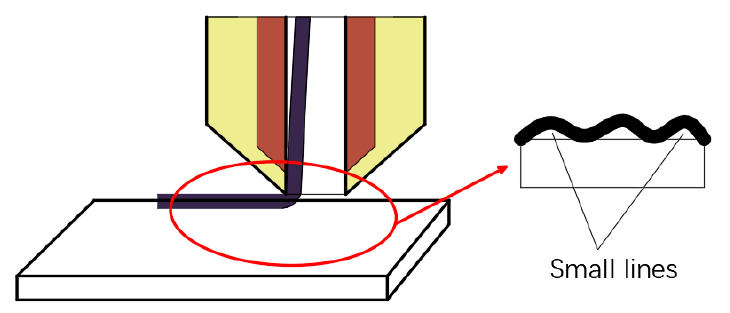
Figure 10. Bonding Figure 10. Bonding model.